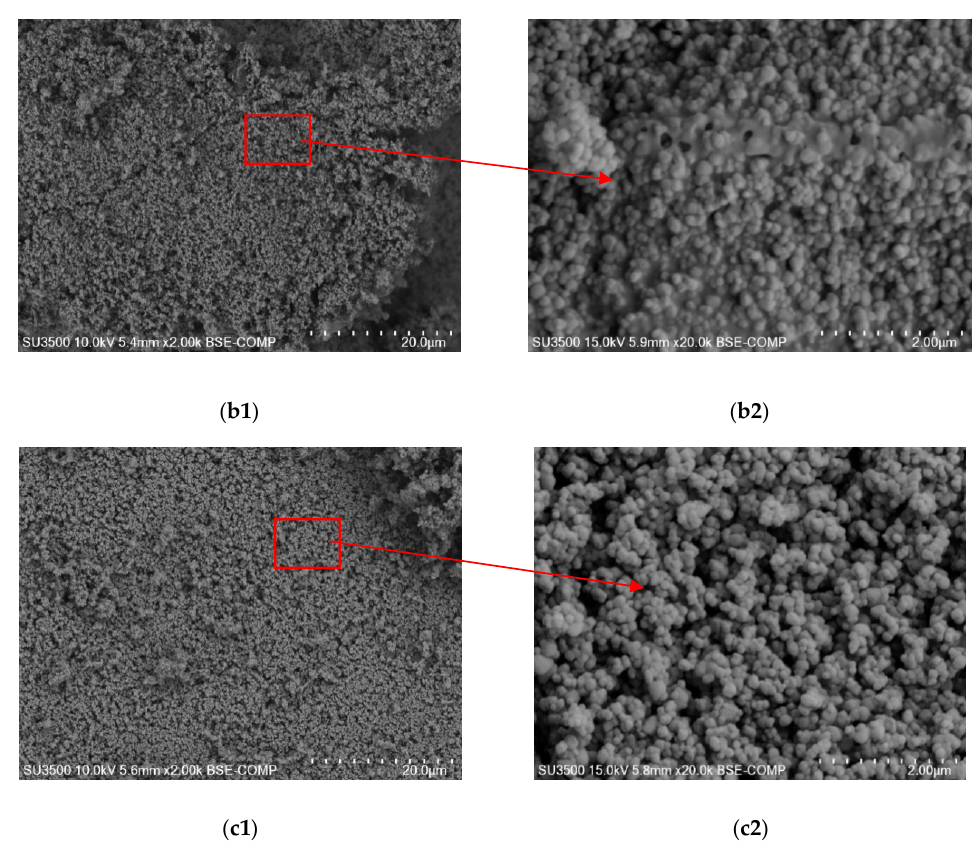
Figure 3. Comparison of SEM images for he pure TiO 2 ( a1,a2 ) and the catalysts modified with pyruvic acid ( b1,b2 ) and succinic acid ( c1,c2 ) in proportions 90:10.